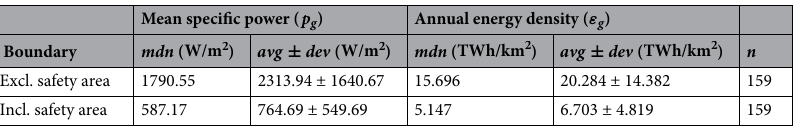
Table 7. Mean and annual power and energy densities for nuclear power plants excluding and including the safety area (considering the data shown in Fig. 4).